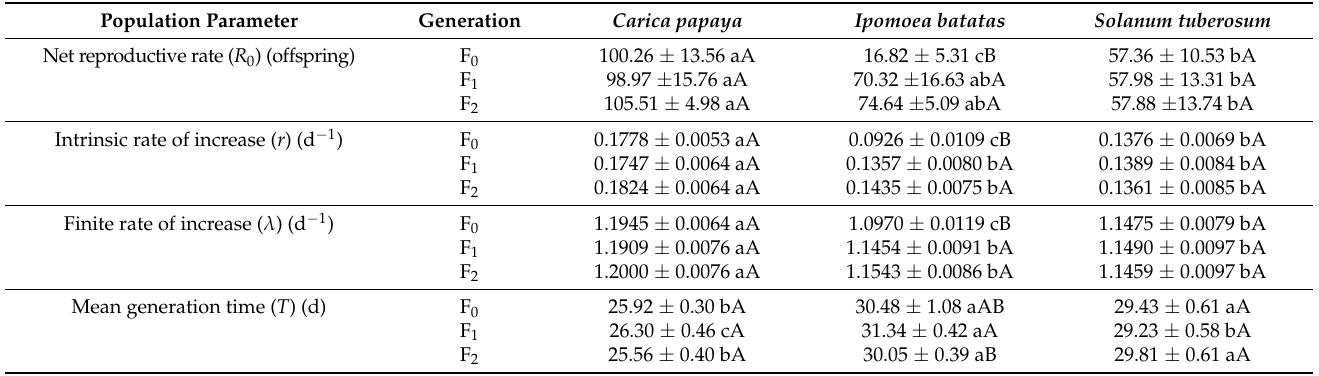
Figure 6. Age-stage-specific reproductive value ( v xj ) rates of Paracoccus marginatus individuals reared on three different host plants (F 0 ). The red vertical dashed line in each figure denotes the total preoviposition period (TPOP). Table 3. Population parameters of Paracoccus marginatus individuals reared on three different host plants (F 0 –F 2